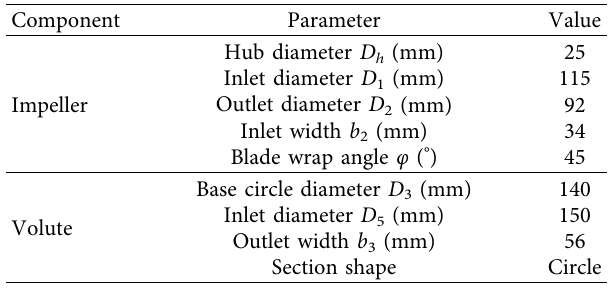
Figure 1: 3D model of the internal flow field of MF-PAT. Table 1: Main geometric parameters of impeller and volute of turbine.